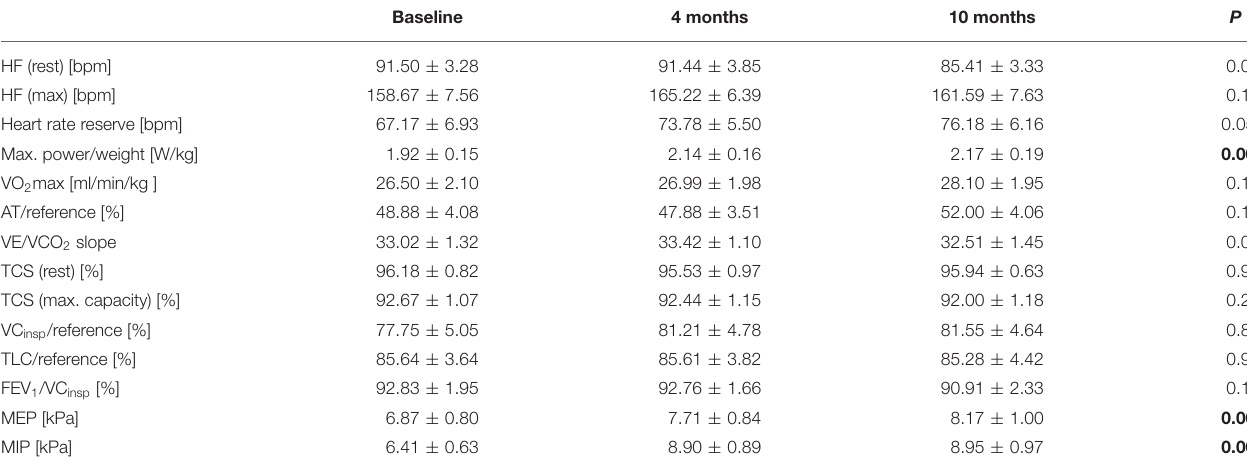
TABLE 3 | Cardiopulmonary exercise testing (CPET, all patients, n =